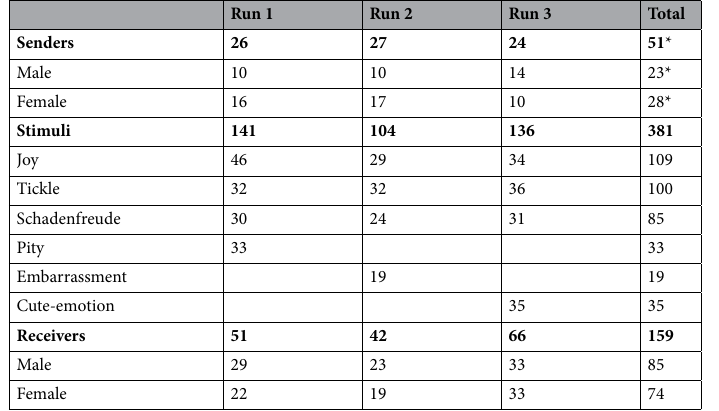
Table 1. Information about the senders, the stimulus set derived from those senders and presented to the receivers, and the receivers for Experiment 1. Because there were too many laughter stimuli to be tested in one single experiment, the experiment was split into three ‘runs’ or ‘waves’ of data collection. Each run was based on different stimuli and participants. *The set of senders partially overlapped for the three runs, resulting in a total which is different to the sum across the